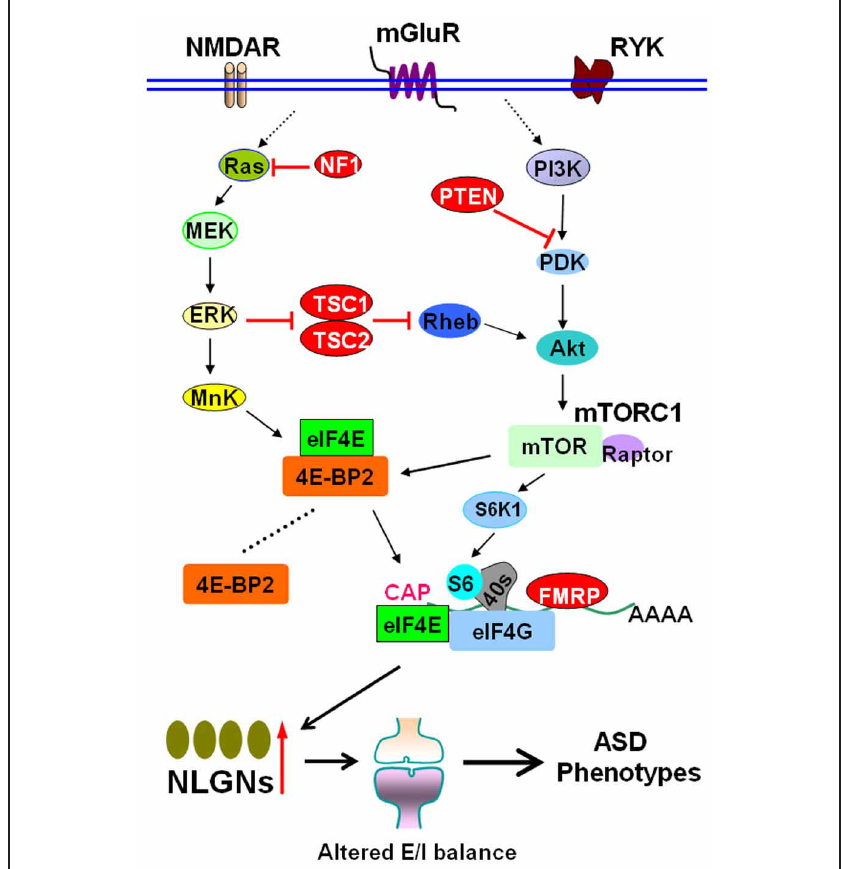
FIGURE 1 | The mTOR signal pathway in autism spectrum disorders. The mTOR pathway integrates inputs from different sources, such as NMDAR, mGluR, and RYK. Activation of mTORC1 promotes the formation of the eIF4F initiation complex. Mutations in TSC1 / 2 , NF1 , and PTEN, or loss of FMRP due to mutations of the FMR1 gene, cause hyperactivity of mTORC1–eIF4E pathway and lead to syndromic ASDs. 4E-BP2 inhibits translation by competing with eIF4G for eIF4E binding. Gkogkas et al. demonstrated that removal of 4E-BP2 or overexpression of eIF4E enhances cap-dependent translation. The increased translation of NLGNs causes increased synaptic E/I ratio, which may eventually lead to ASD phenotypes. Abbreviations: Akt, also known as PKB, protein kinase B; ASD, autism spectrum disorder; 4E-BP2, eIF4E-binding protein 2; E/I, excitation/inhibiton; ERK, extracellular signal regulated kinase; FMRP, fragile X mental retardation protein;